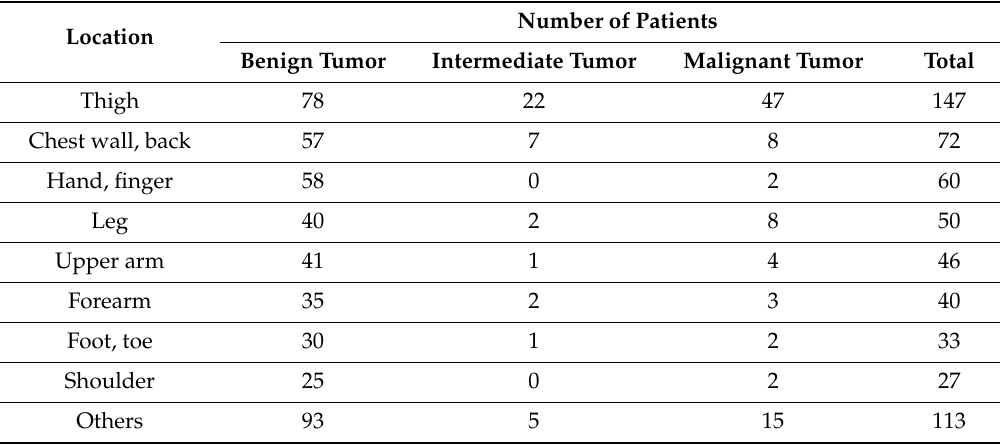
Table 2. Location of tumors.